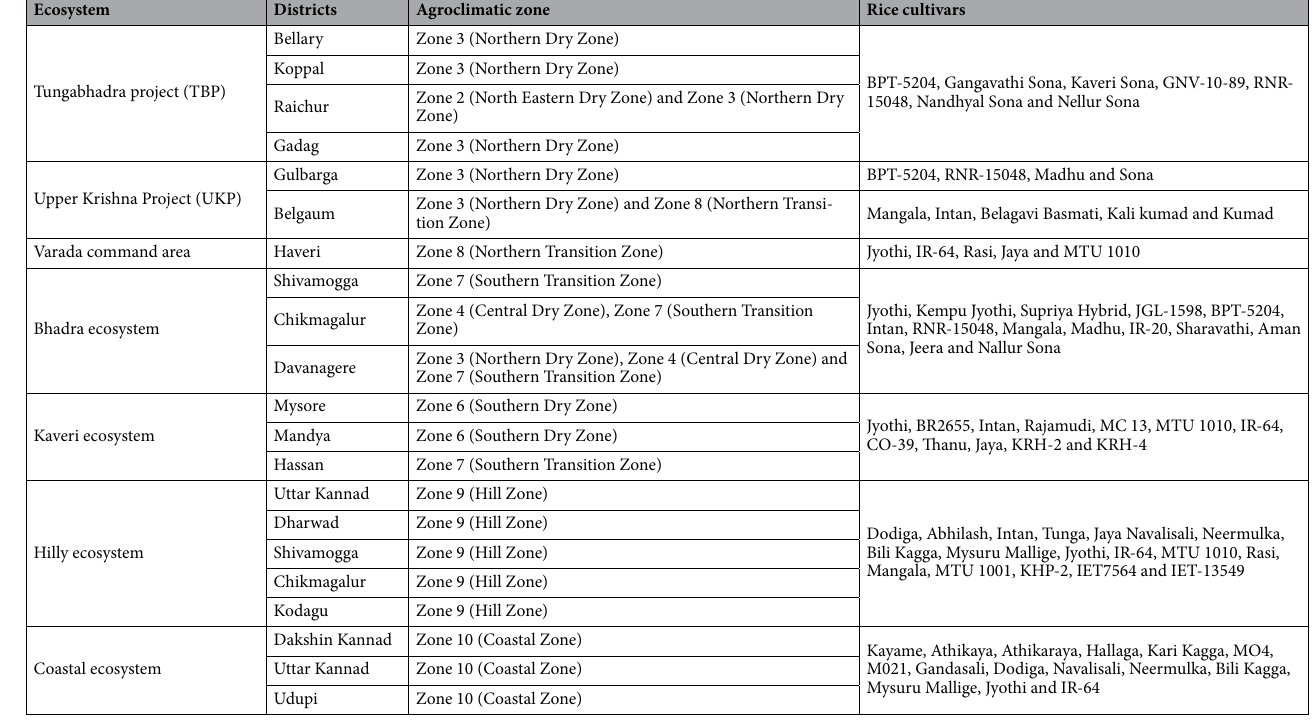
Table 1. Details of diverse rice-growing ecosystems selected for the study.